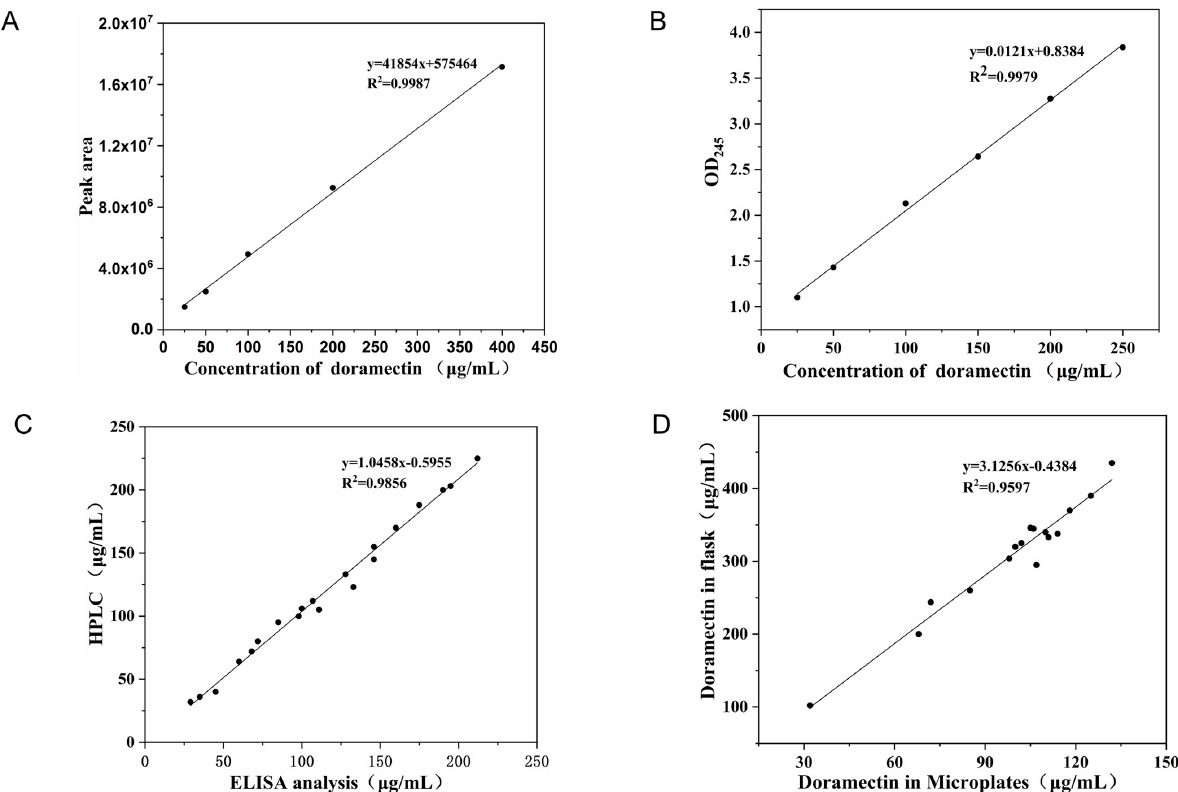
Figure 2. Analysis of the correlation between doramectin ELISA assay and HPLC quantification. ( A ) doramectin HPLC standard curve, ( B ) doramectin ELISA standard curve, ( C ) correlation of HPLC assay with ELISA method, ( D ) correlation of single-colony microplate surface culture with shake flask fermentation.